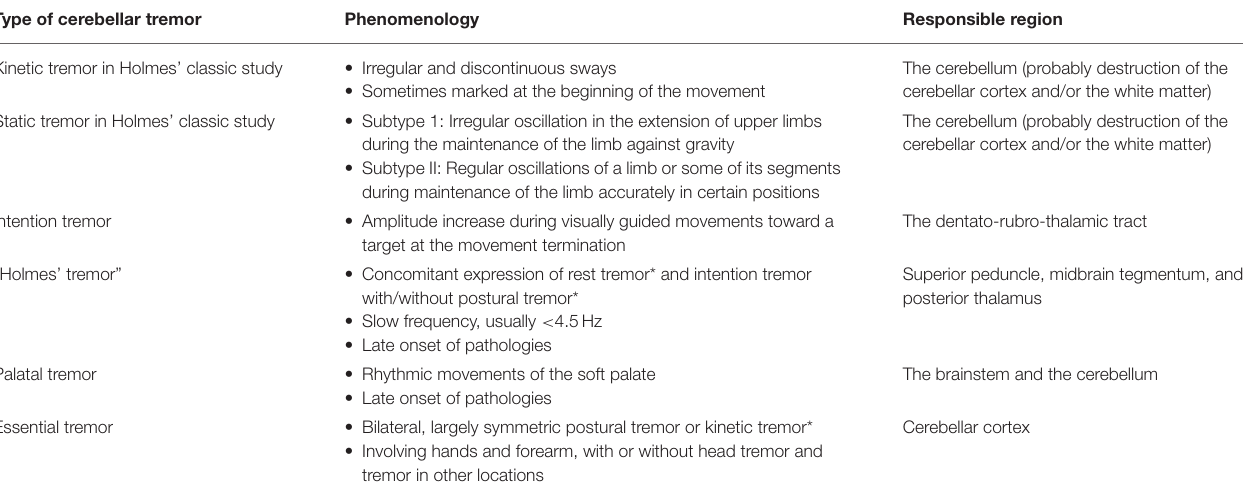
TABLE 2 | Phenotypes in cerebellar